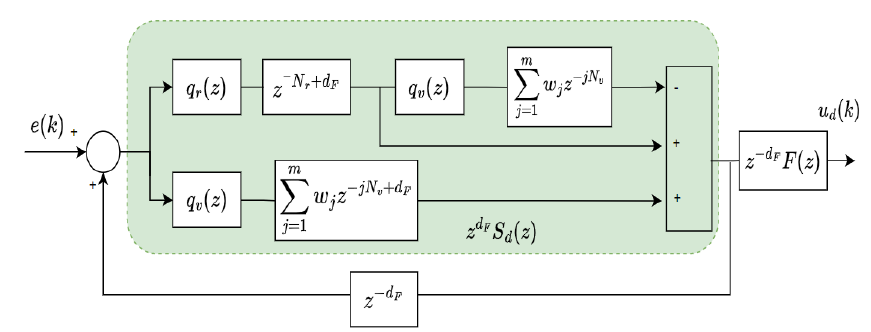
Figure 5. Realization of the DIMRC with non − causal stabilizing